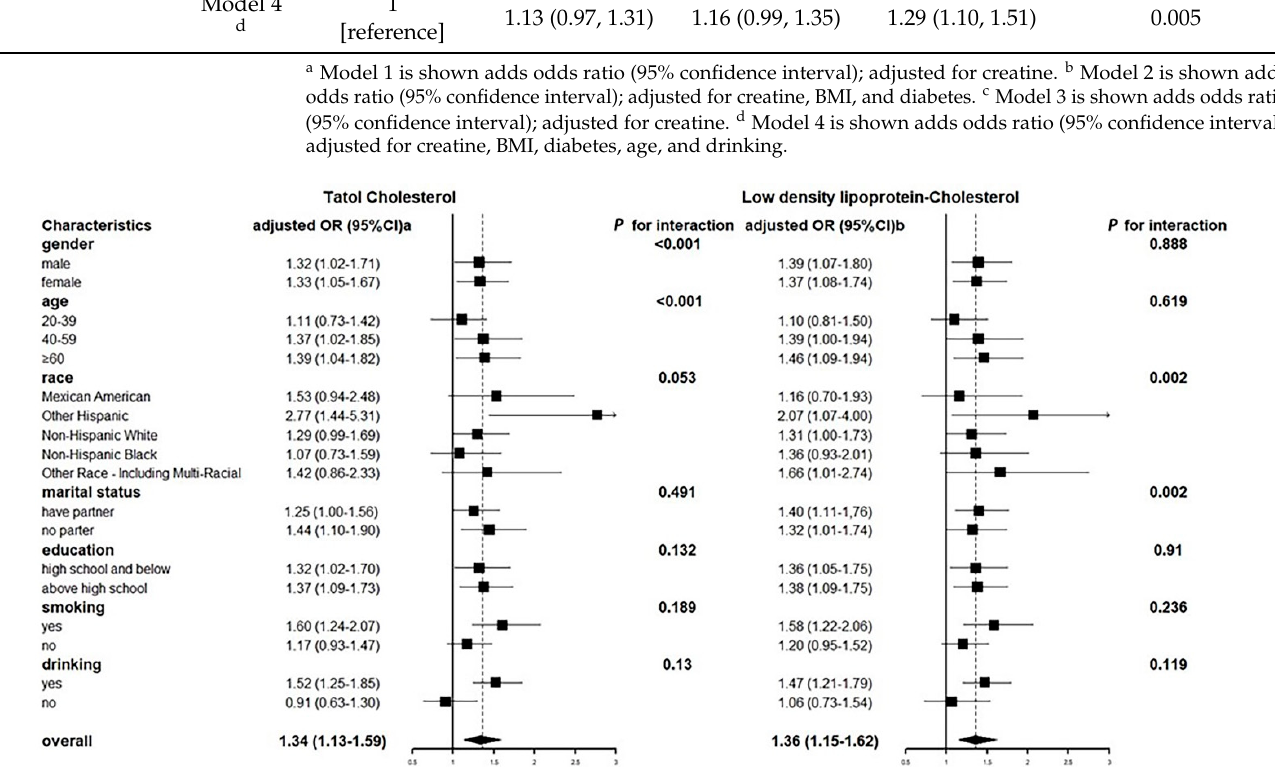
Table 5. Unadjusted odds ratios (OR) and 95% confidence intervals (CI) of the association between TC and LDL-C and speciated arsenic.